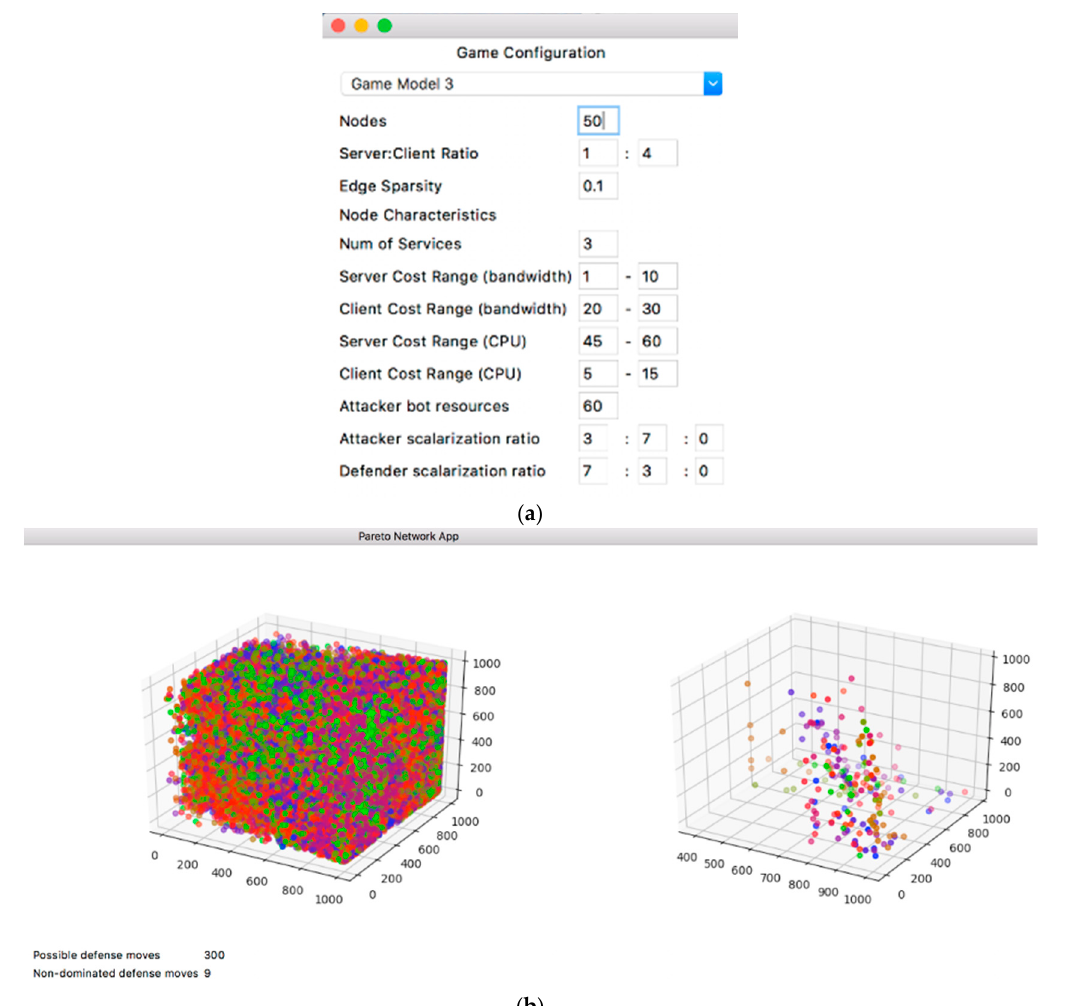
Figure 12. PDSSS analysis for large scale network. ( a ) Control panel; ( b ) Results display.